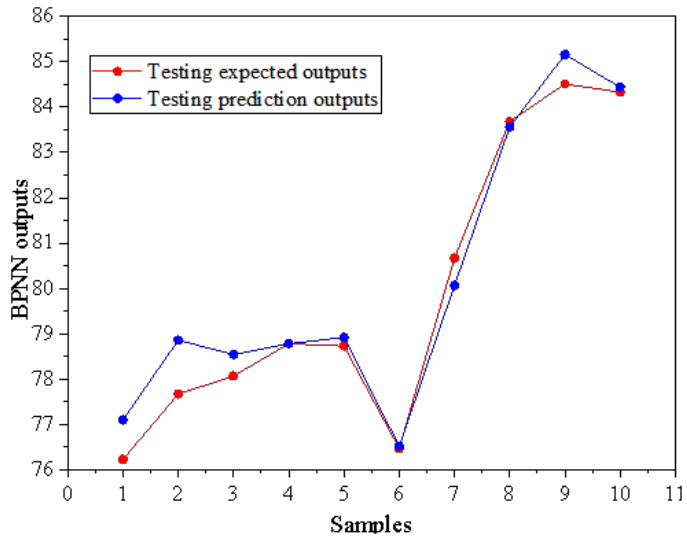
Table 2. Values of genetic algorithm parameters design. Figure 14. Comparison of predicted values between BPNN and regression analysis.